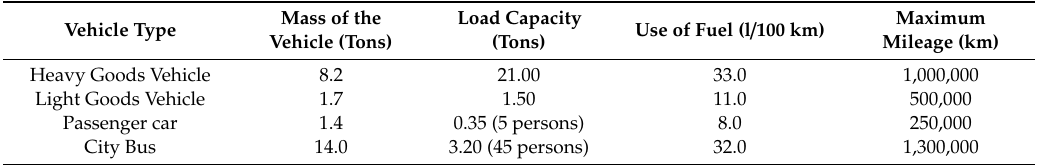
Table 9. Assumptions applied to transportation